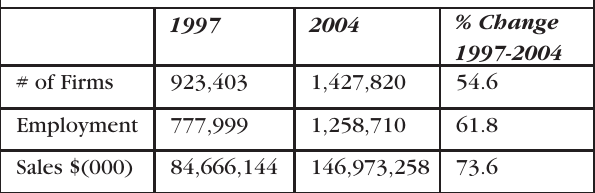
Table 1. Growth in